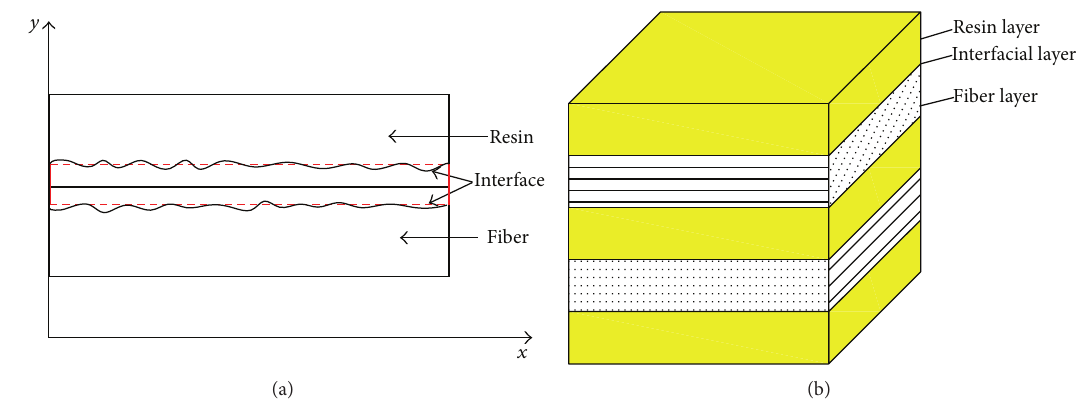
Figure 1: (a) Representative volume element (RVE); (b) equivalent model of